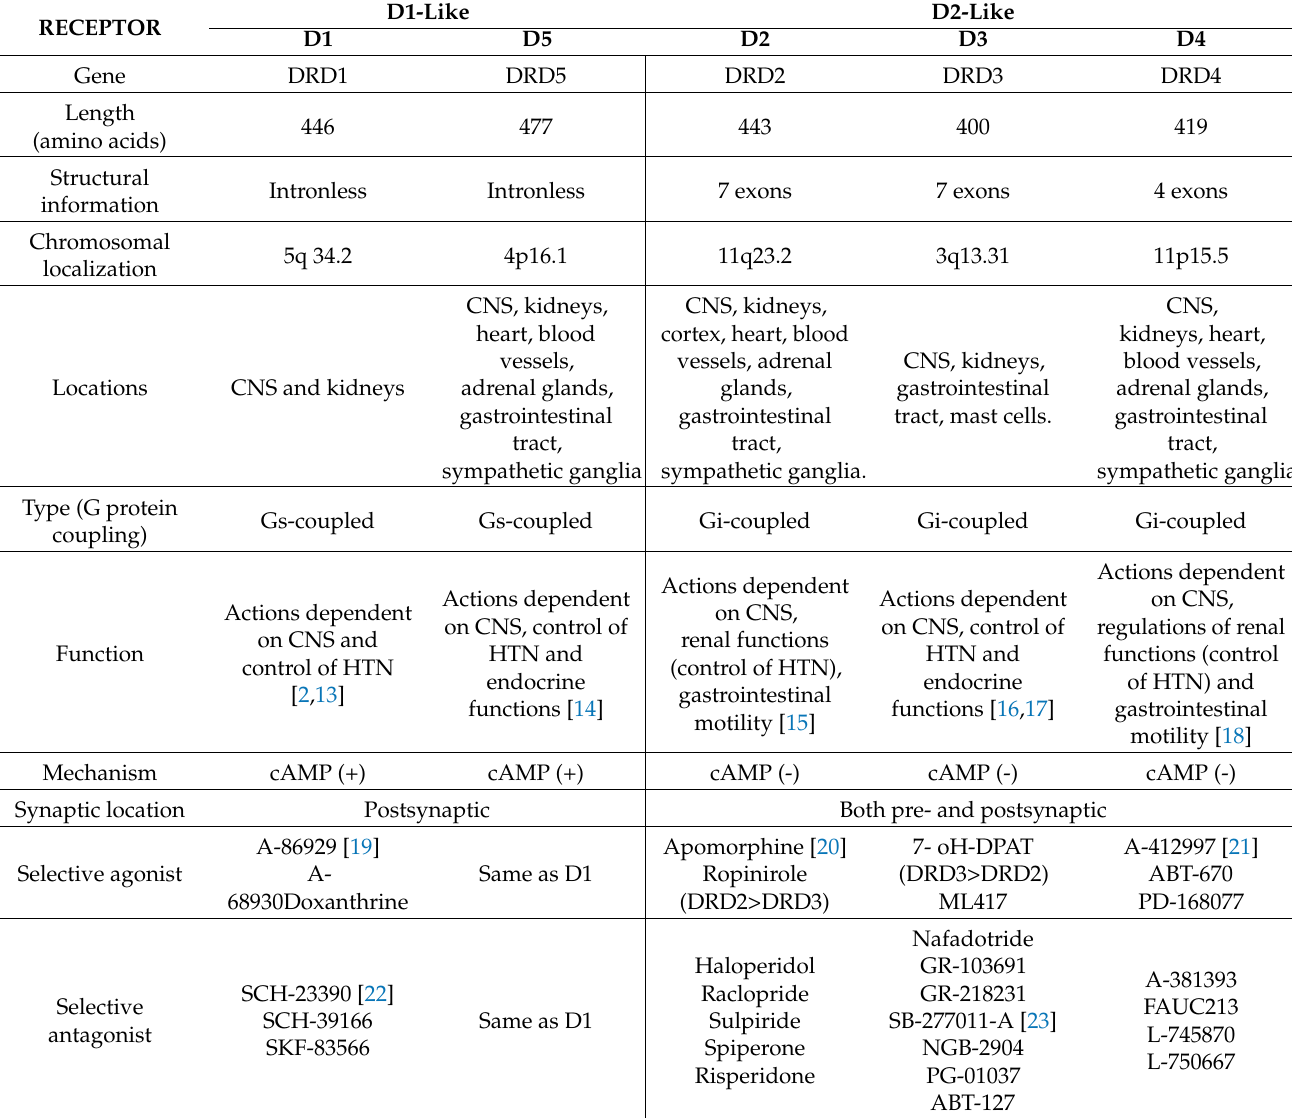
Table 1. Dopamine receptor subtypes classified by distribution, function, mechanism of action, agonist, and antagonist.